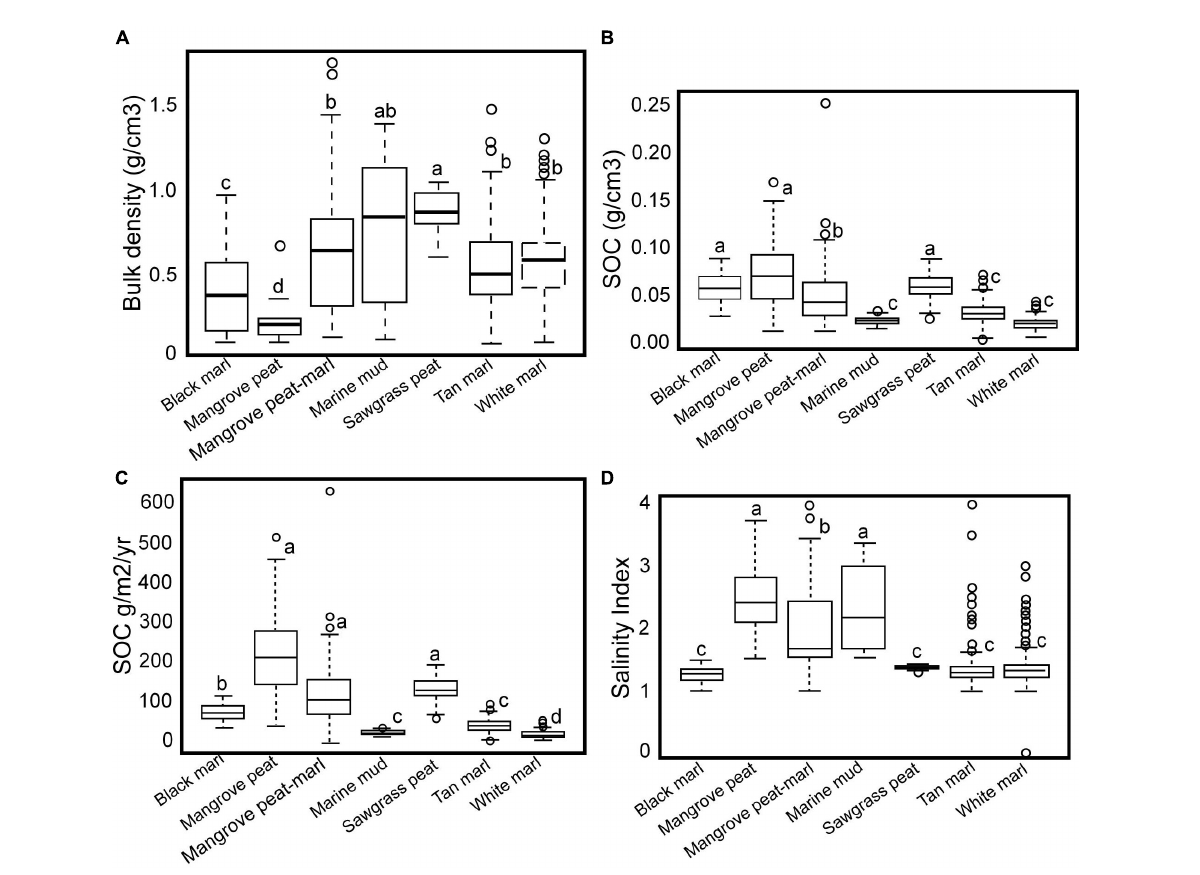
FIGURE3 (A) Box-plot illustrating the relationship among bulk density and sediment types. (B) Box-plot illustrating the relationship among SOC density (SOC g/cm 3 ) and sediment types. (C) Box-plot illustrating the relationship among the rate of SOC accumulation (SOC g/cm 2 /yr) and sediment types. (D) Box-plot illustrating the relationship among the Salinity Index and sediment